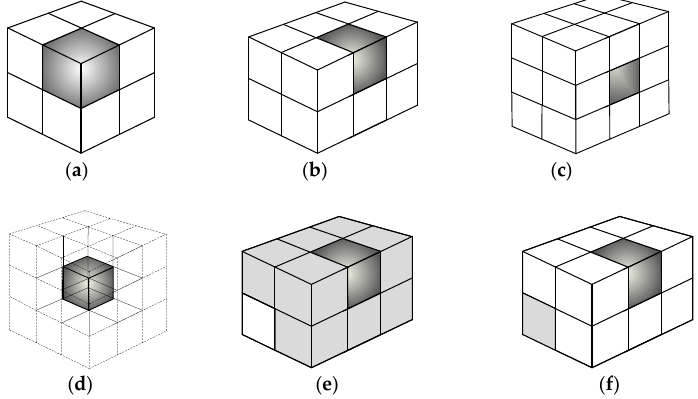
Figure 1. The adjacent relation between space pixels. ( a ) The space pixels are located on the eight corners; ( b ) The space pixel is located in the middle of the side boundary; ( c ) The space pixel is located in the center of the plane; ( d ) The space pixel is located in the center of the cubic; ( e ) The space pixels are adjacent to the boundary of the i th space pixel; ( f ) The space pixels are adjacent to the vertex of the i th space pixel.